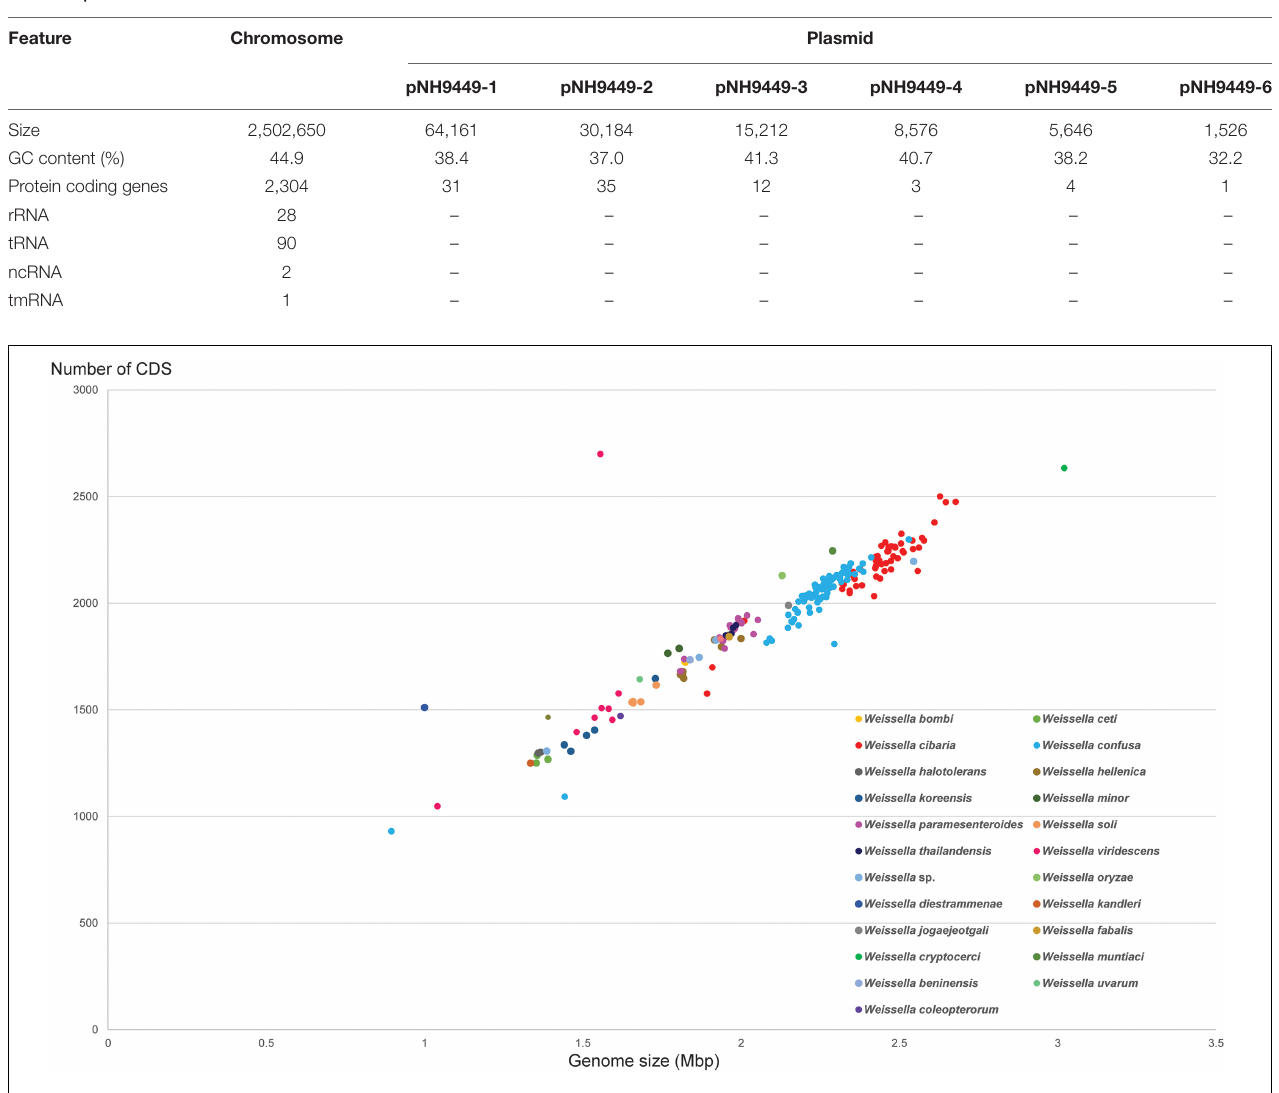
TABLE 1 | Genome features of W. cibaria NH9449.